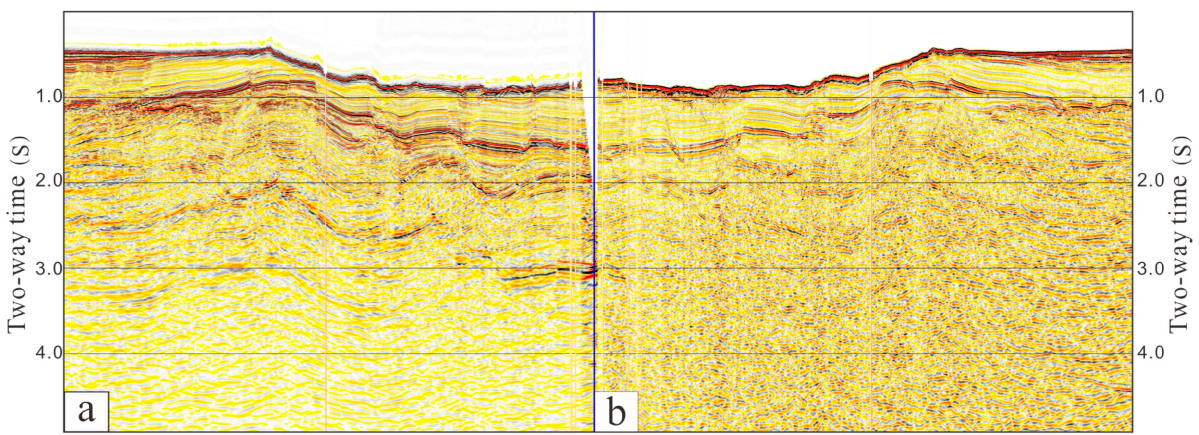
Figure 9. Effect comparison of the prestack time migration profile (( a ). quasi-3D PSTM; ( b ). 2D